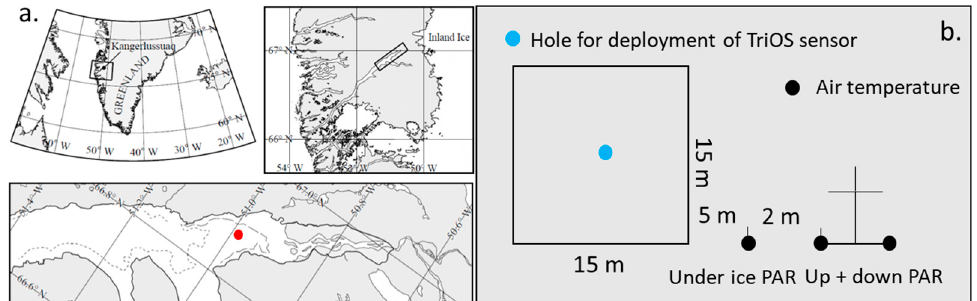
Figure 1. Red dot shows the location of the study site in the inner reach of Kangerlussuaq ( a ) (map redrawn from Nielsen et al. 2010), and optical field site with placement of sensors (not to scale) and spectral measurement site ( b ). Spectral data (TriOS) were obtained on 14 March and continous upwelling, downwelling, and under-ice PAR data were obtained from mid 12 to mid 19 March.